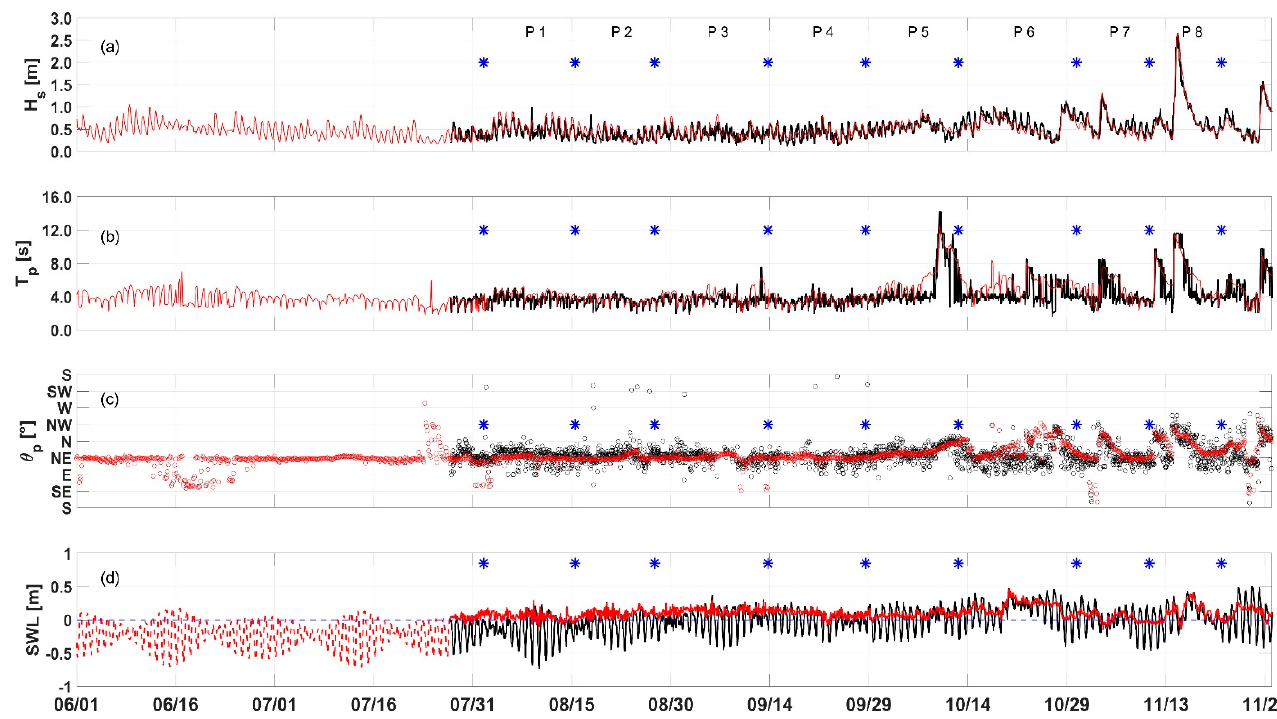
Figure 2. ADCP wave and tidal conditions. Offshore significant wave height ( a ), peak wave period ( b ), peak wave angle ( c ), and surface water level ( d ) during the study. For panels ( a – c ), red continuous lines are WaveWatch III data, and black lines are measured data. The blue stars correspond to the survey dates, and the numbers correspond to each “period” analyzed. In panel ( d ), the astronomical tide is shown from June to the end of July; the black continuous line (August to November) is the measured SWL, and the red continuous line is the residual tide (=SWL − astronomical tide).